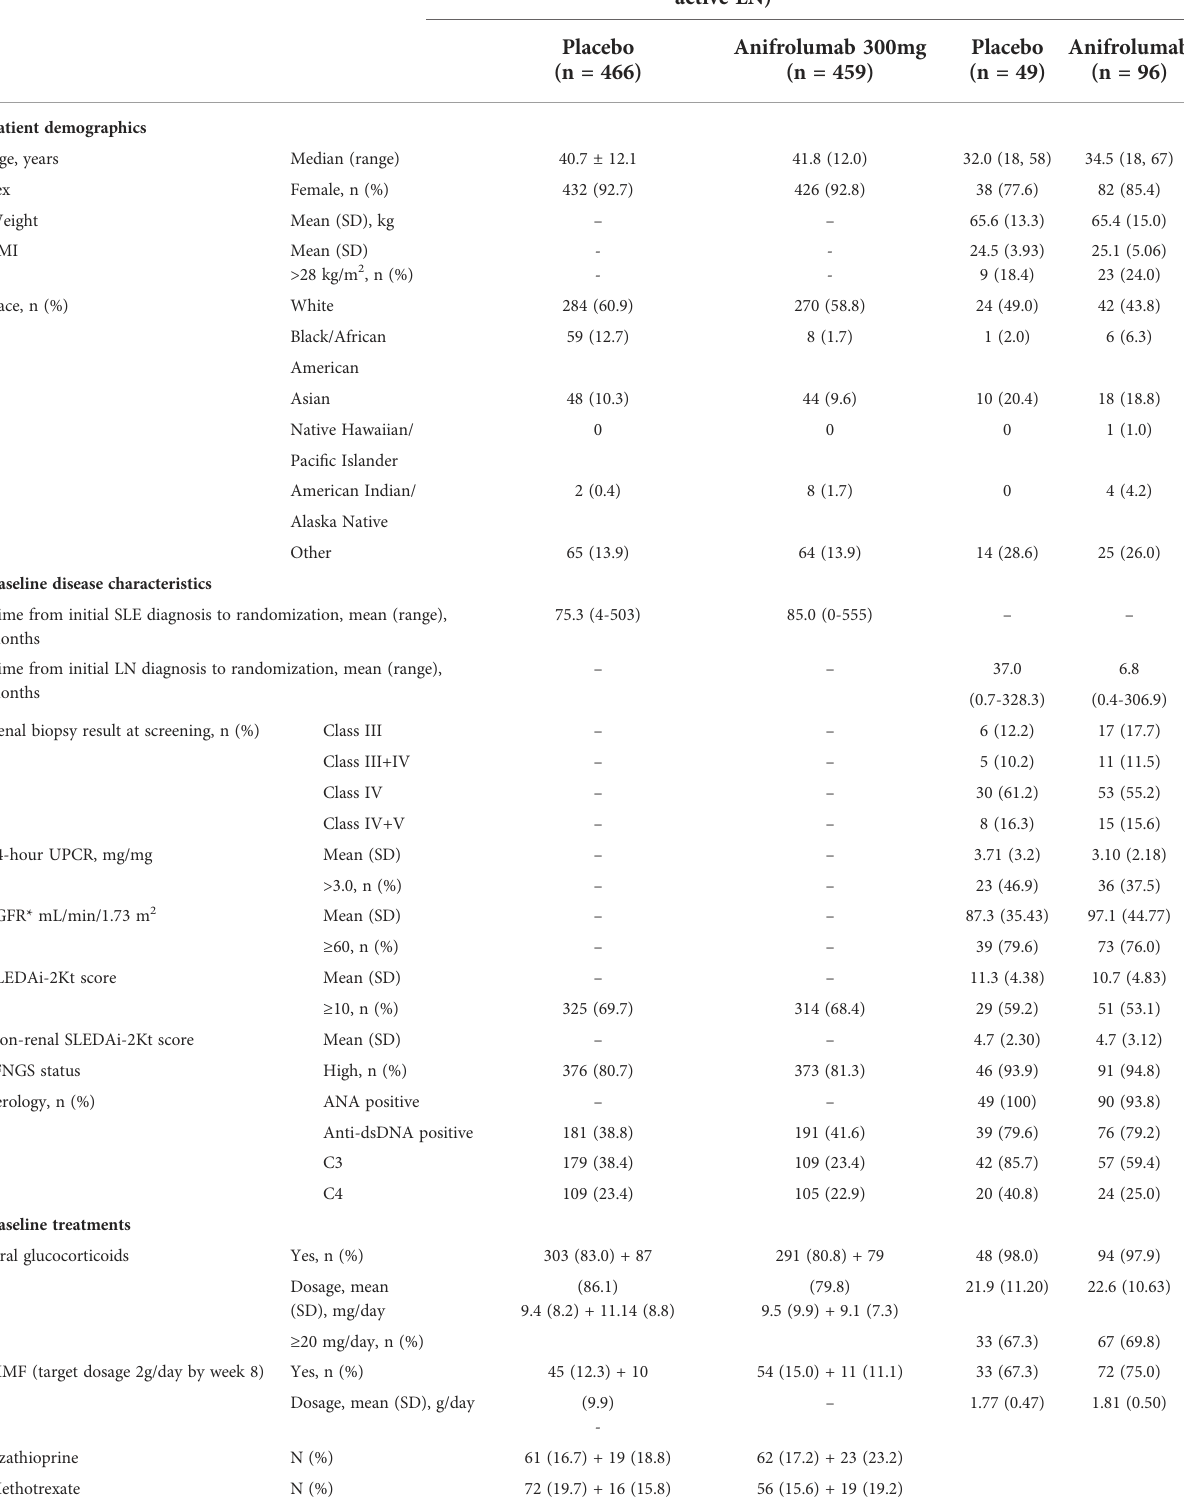
TABLE 1 Patient demographics and baseline/disease characteristics from the TULIP1, TULIP2, MUSE and TULIP-LN clinical